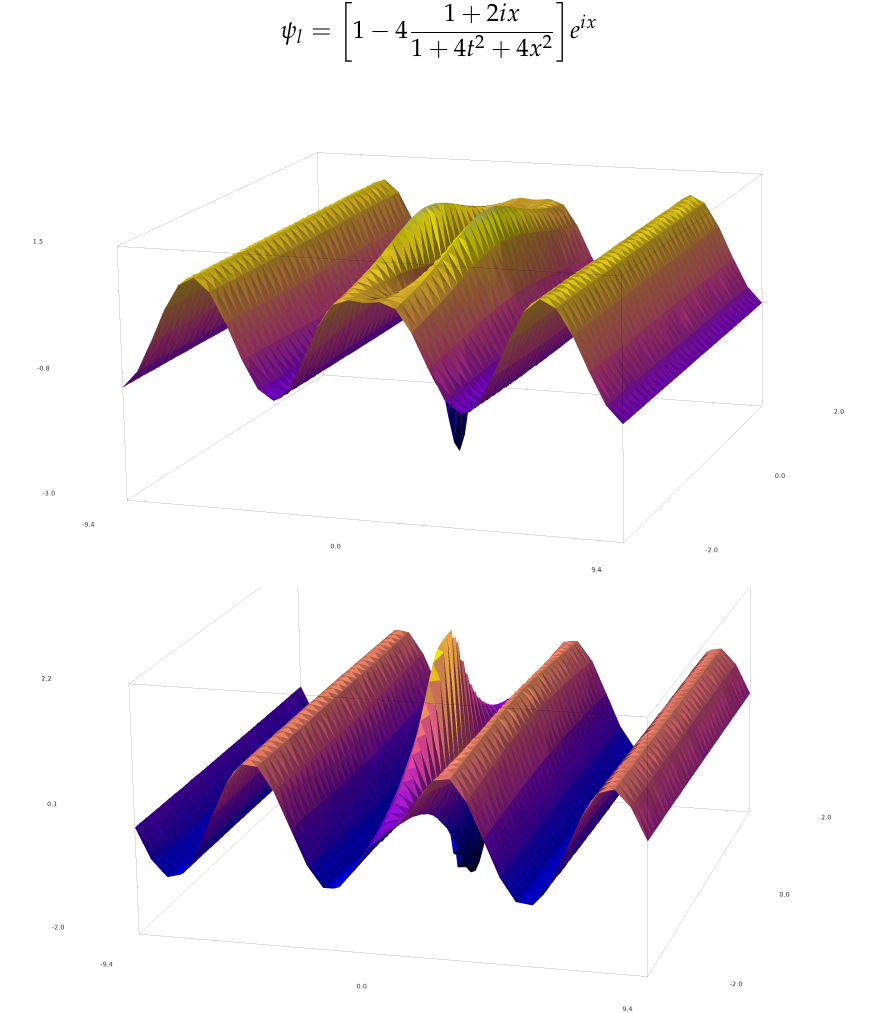
Figure 2. The plot of ψ 1 , the first-order solution to the standard NLSE [19]. Real and imaginary parts shown respectively above and below. Plotted with SageMATH